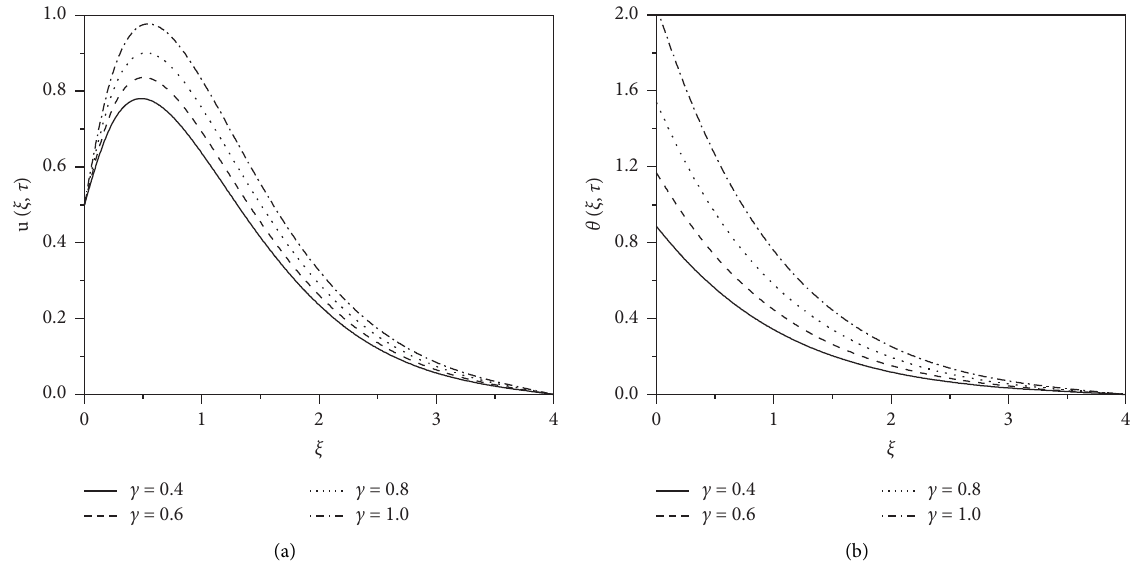
Figure 6: Variation of (a) velocity u ( ξ , τ ) and (b) temperature θ ( ξ , τ ) against ξ for various values of c .